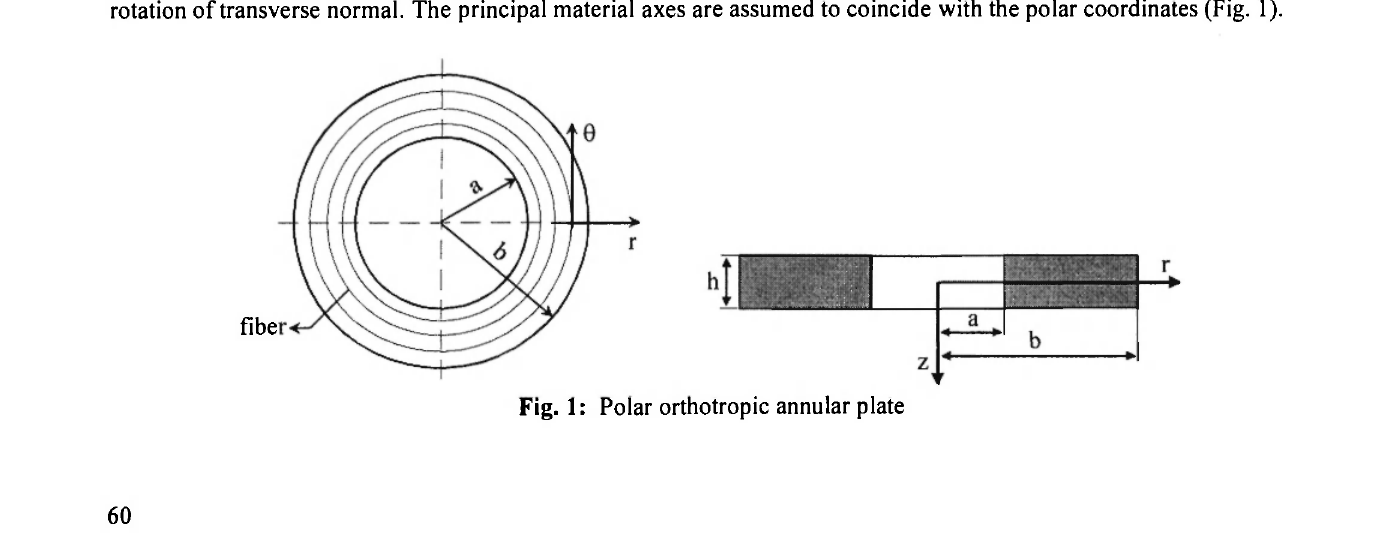
Fig. 1: Polar orthotropic annular